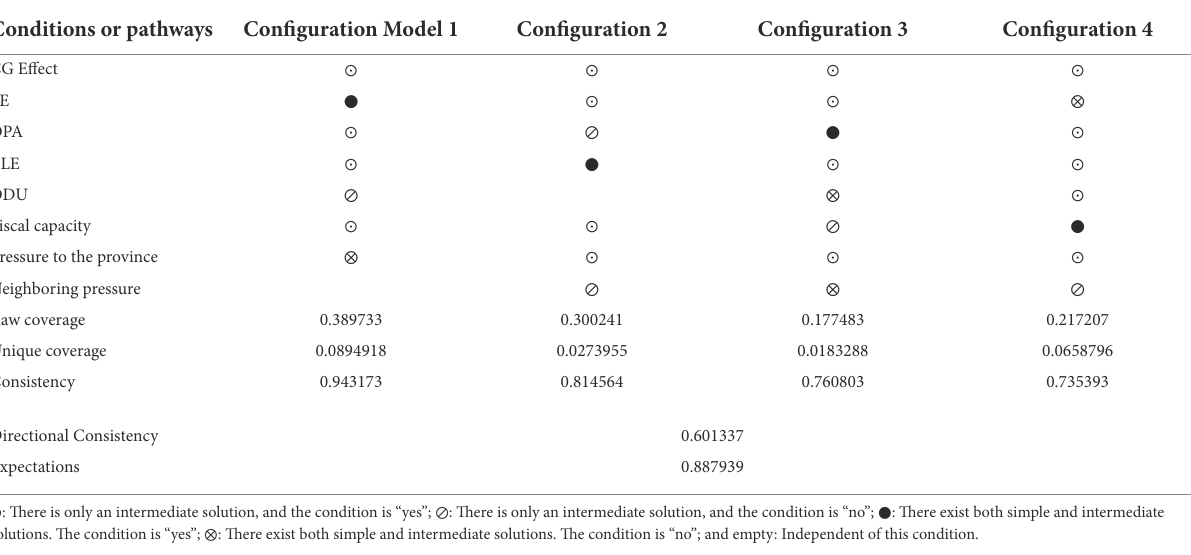
TABLE 6 Conditional configuration analysis of honesty effect in the provincial government (2019-2020).